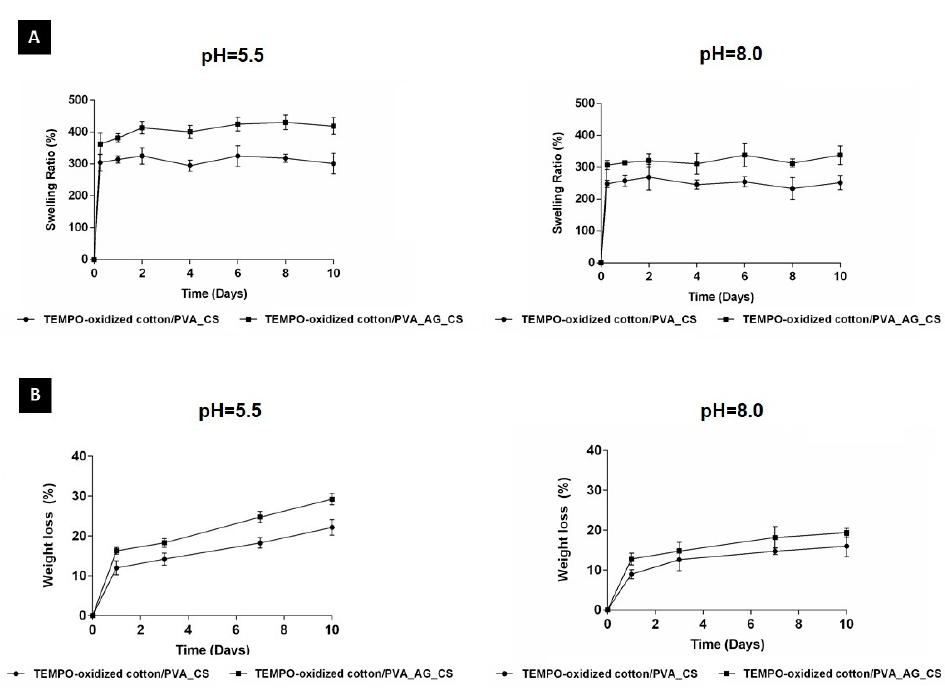
Figure 4. Characterization of the TEMPO-oxidized cotton/PVA_CS materials with and without crude AG extract incorpo- rated. Swelling profile ( A ); weight loss at pH = 5.5 and pH = 8.0 ( B ).